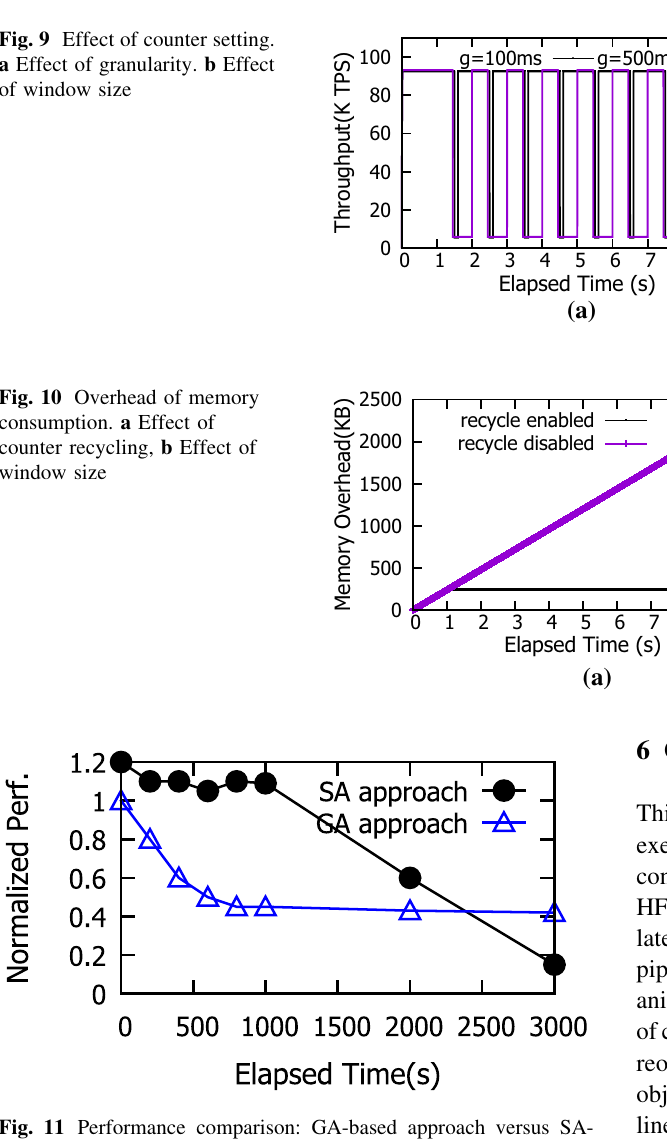
Fig. 11 Performance comparison: GA-based approach versus SA- based